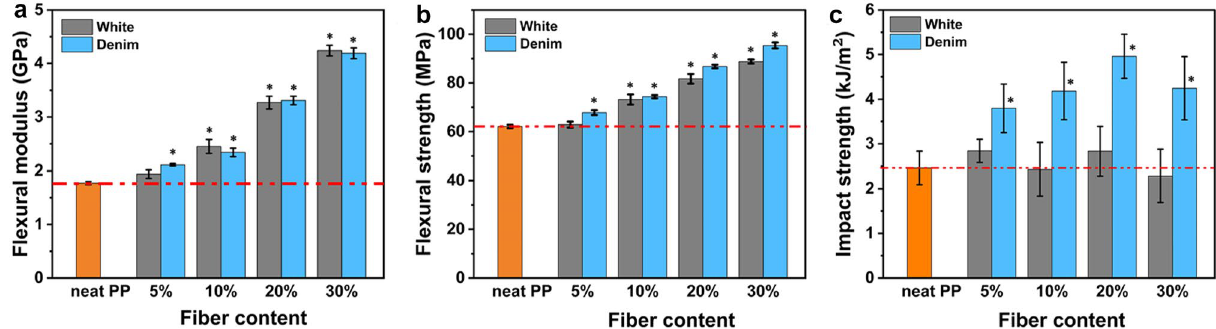
Figure 5. Graphs for the ( a ) flexural modulus, ( b ) flexural strength, and ( c ) impact strength of neat PP and ASA-SMC-cotton/PP composites with different fiber loadings. The star indicates the difference with neat PP was significant (p < 0.05) using Student’s